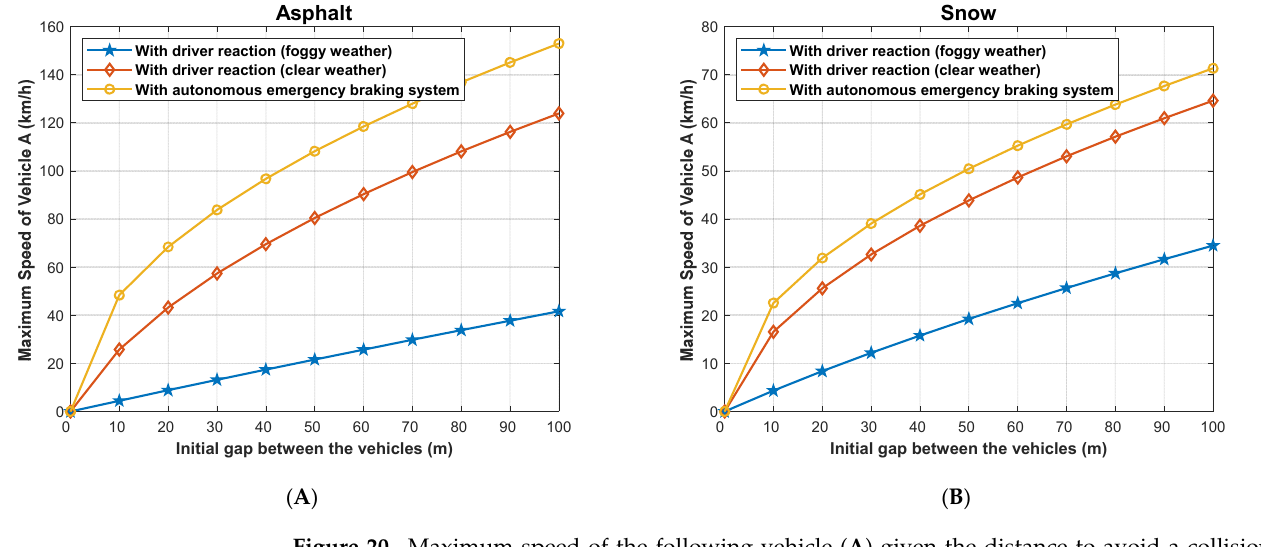
Figure 20. Maximum speed of the following vehicle ( A ) given the distance to avoid a collision, assuming that the followed vehicle ( B ) stops suddenly.